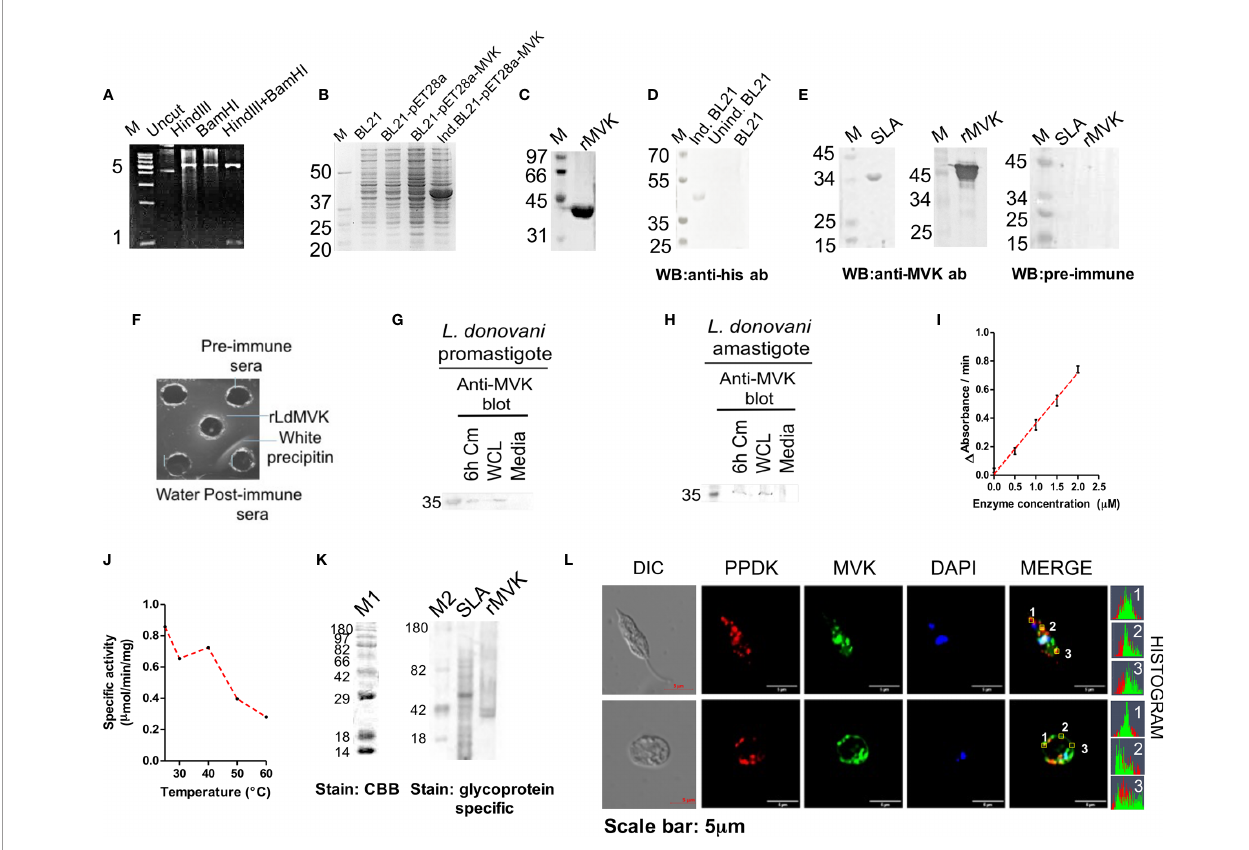
FIGURE 2 | Characterization of L. donovani mevalonate kinase. (A) Figure showing con fi rmation of cloning after HindIII+BamHI double digestion of rpET28a-MVK. HindIII+BamHI double digested product was run on agarose gel electrophoresis. M, DNA ladder; uncut, uncut pET28a-MVK; HindIII, HindIII digested recombinant plasmid; BamHI, BamHI digested recombinant plasmid; HindIII+BamHI, double digested HindIII+BamHI rpET28a-MVKproduct. Representative of at least three independent experiments is shown. (B) SDS-PAGE showing the expression of rLdMVK by induced and transformed BL21 cells. M, Protein marker; BL21, bacterial cell lysate; BL21-pET28a, pET28a transformed bacterial lysate; BL21-pET28a-MVK, pET28a-MVK transformed bacterial lysate; Ind. BL21-pET28a-MVK, pET28a- MVK transformed and induced bacterial lysate. (C) Ni-NTA puri fi ed sample stained with Coomassie brilliant blue. This puri fi ed r-LdMVK was used for all